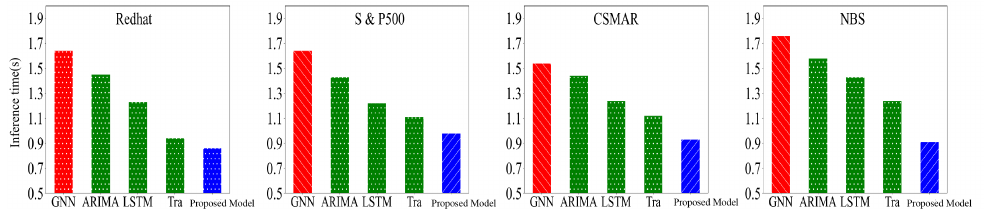
Figure 11. Comparison of inference speed for different